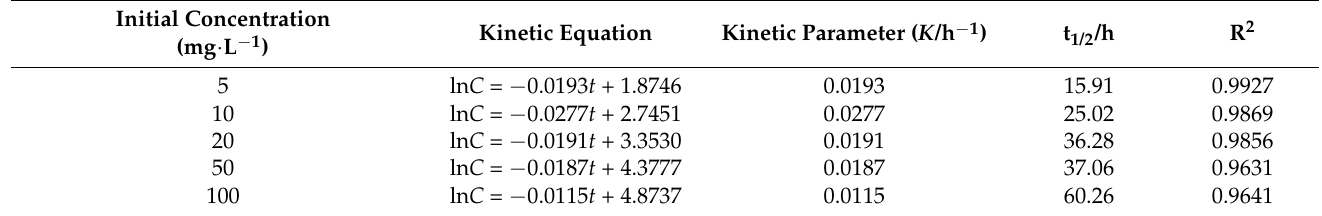
Table 5. Degradation kinetics equations of Acinetobacter baumannii DP-2 at different initial DBP concentrations.